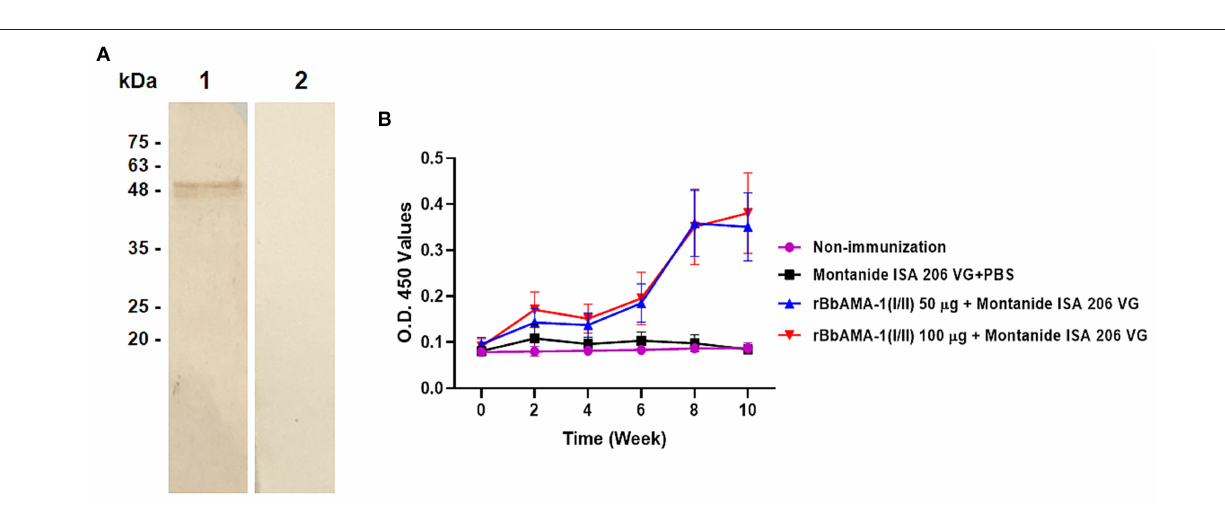
FIGURE 2 | Determination of rBbAMA-1(I/II)-specific antibody response. (A) Western blotting analysis demonstrated that pooled cattle serum immunized with rBbAMA-1(I/II) reacted with the purified recombinant protein (lane 1) when compared to the pre-immunization period (lane 2). (B) Indirect ELISA test revealed that the antibody response continuously increased after the first immunization with